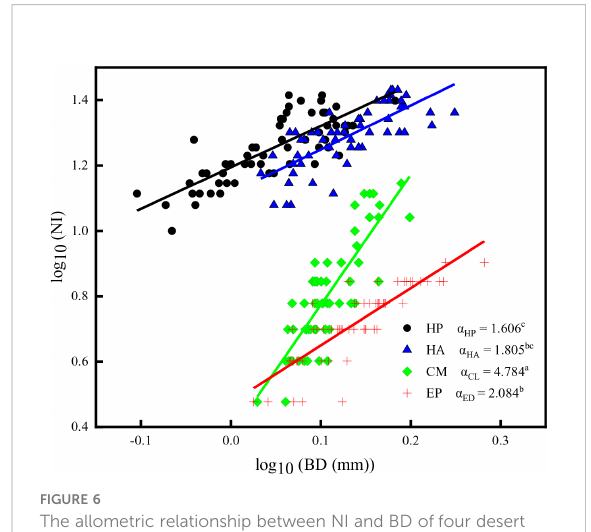
FIGURE 6 The allometric relationship between NI and BD of four desert shrubs; Species: HP = Haloxylon persicum , HA = Haloxylon ammodendron , CM = Calligonum mongolicum , and EP = Ephedra przewalskii ; NI = Number of internodes, BD = Average basal diameter of assimilative branches. Different lowercase letters in the upper right-hand corner of the plot of scaling exponents ( a ) represent signi fi cant differences (P <